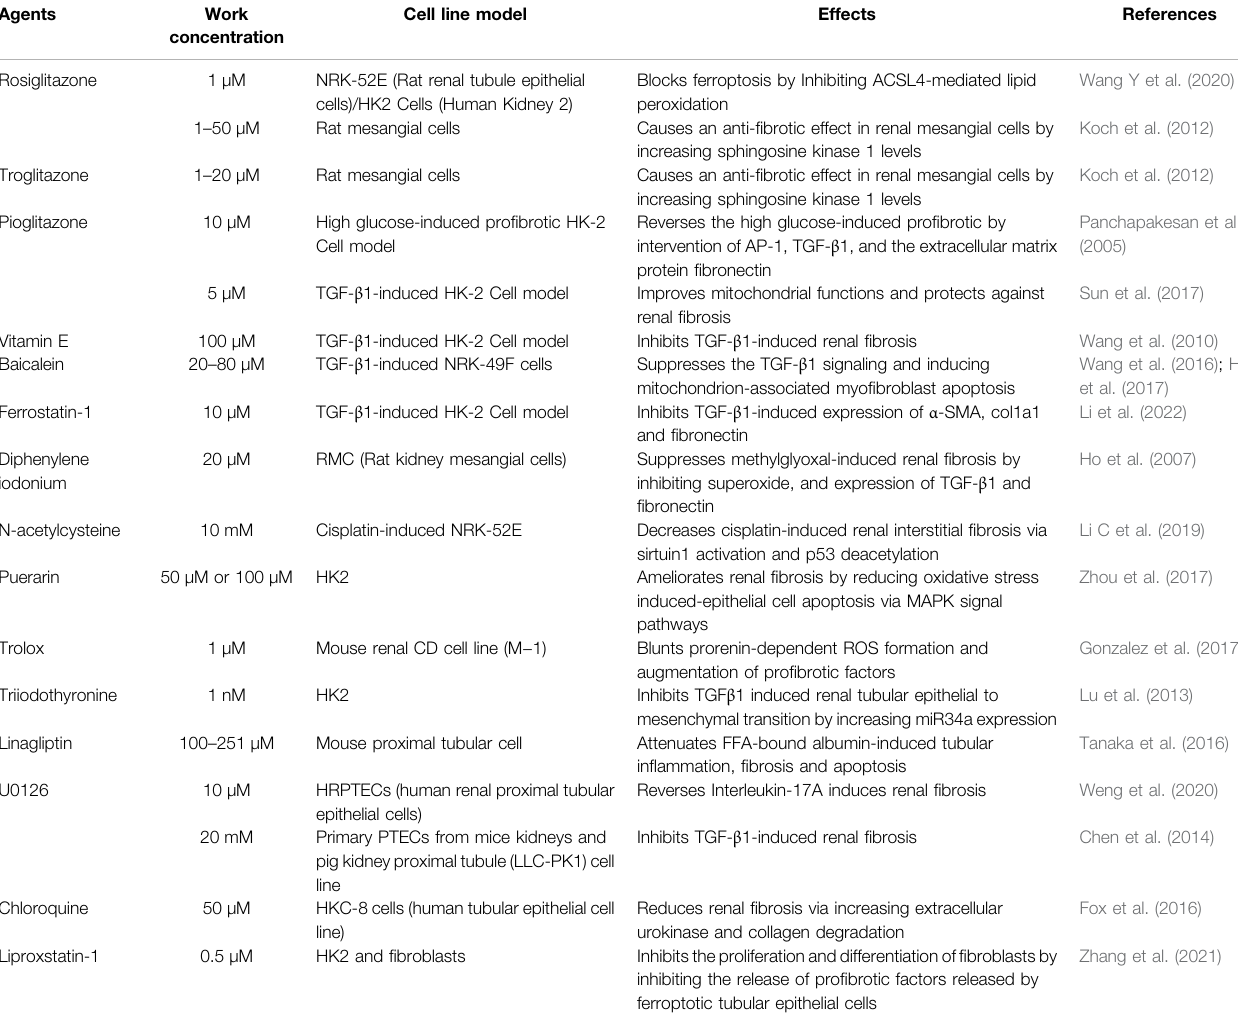
TABLE 1 | Evidence of ferroptosis inhibitors alleviates renal fi brosis in vitro .